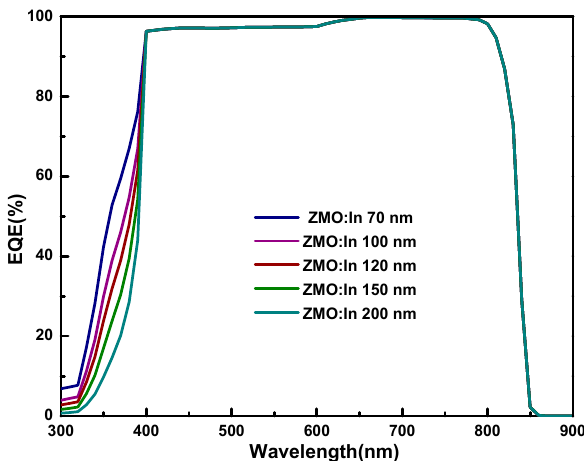
Figure 8. Thickness dependence of external quantum efficiency of CdTe solar cells on ZMO:In(x = 0.0625) film.